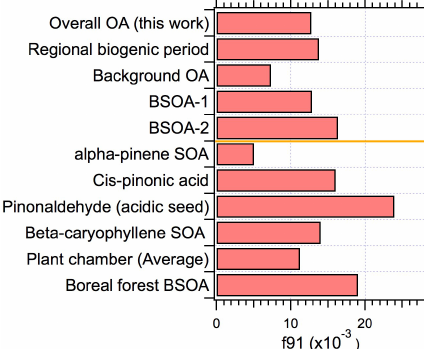
Figure 6. The mass fraction of m/z 91 ( f 91 ) observed in this study (overall OA, regional biogenic period, background OA, BSOA-1, and BSOA-2), α -pinene and β -caryophyllene SOA generated by chamber experiments (Chen et al., 2015), pinonaldehyde uptake on sulfuric acid seeds (Liggio and Li, 2006), plant chamber SOA (Kiendler-Scharr et al., 2009), cis-pinonic acid (Lee et al., 2012), and BSOA observed in boreal forest in Finland (Finessi et al.,